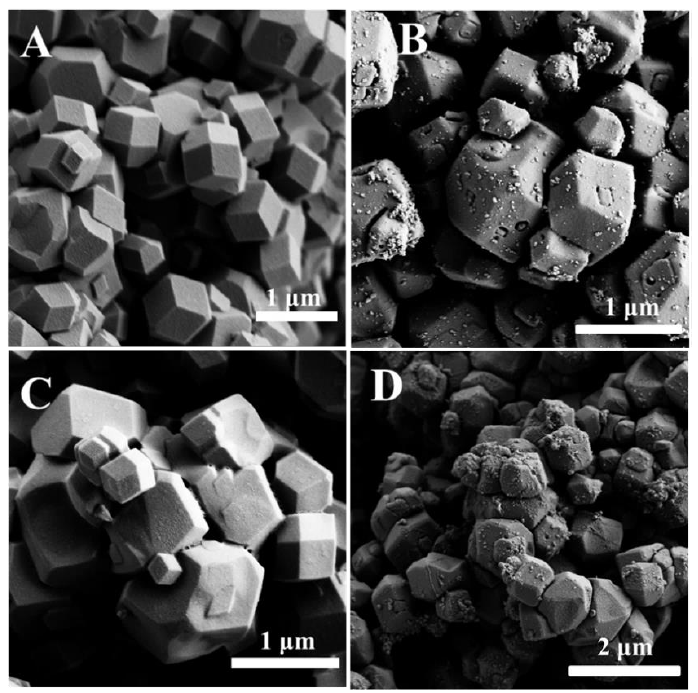
Figure 1. The SEM images of ( A ) ZIF-8, ( B ) AuNPs/ZIF-8, ( C ) PCs, and ( D ) AuNPs/PCs.